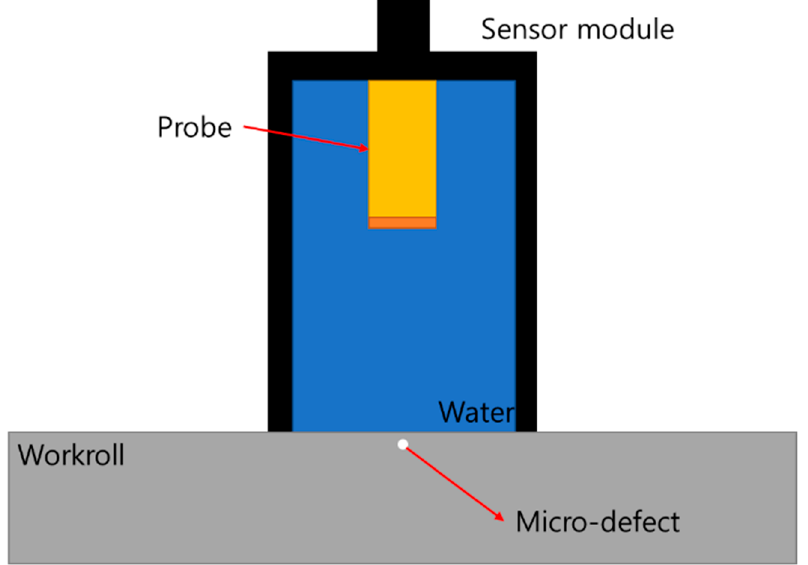
Figure 2. Schematic of ultrasonic inspection of the work roll.